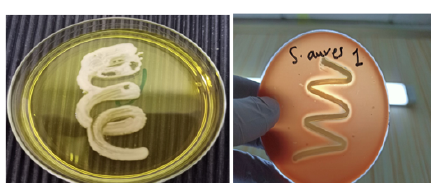
Figure 1. Staphylococcus aureus on blood agar and Mannitol salt